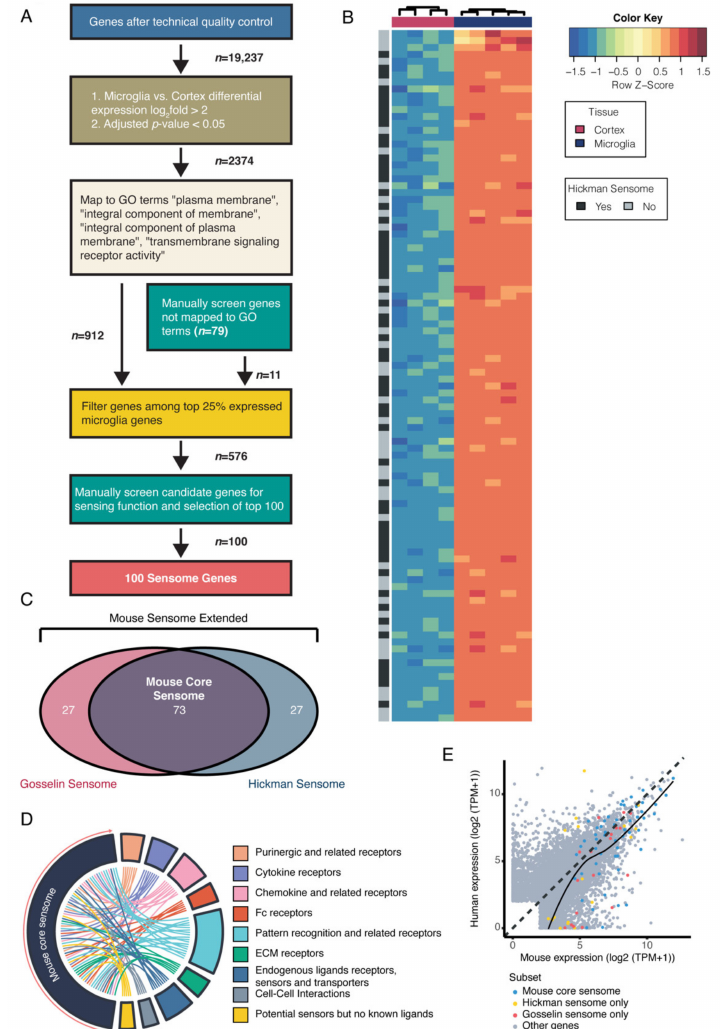
Figure 1. Identification of microglial mouse sensome shows major overlap between two independent datasets. ( A ) Flow chart showing selection of genes from the Gosselin et al. mouse datasets to identify the n = 576 candidate sensome genes. First, technical quality control was performed and genes with a low number of reads per sample were excluded. Second, differential expression analysis with a cut-off of log 2 fold >2 and p -adjusted value <0.05 was used to select genes significantly expressed by microglia. Third, using gene ontology (GO) annotation, we selected genes with association to “plasma membrane”, “integral component of membrane”, “integral component of plasma membrane”, and “transmembrane signaling receptor activity” (genes not mapped were manually curated). Fourth, the top 25% expressed genes were selected as candidate sensome genes. Finally, from the candidate sensome genes, the top 100 were manually verified using the criteria that these should express genes that translate in proteins that are present in the cell membrane and have a receptor-like function. In summary, these genes are highly expressed and specific to microglia and their respective proteins are located in the plasma membrane, where it has a receptor-like function. ( B ) Heatmap showing the first 100 sensome candidate genes (left to right) ordered by differential expression between cortex and microglia (low to high), with the upper row showing if the gene is present in “Hickman et al.”. (Supplementary Table S2). ( C ) Venn diagram showing the overlap between the top 100 Gosselin and Hickman mouse sensome genes (Supplementary Table S2). This total set is termed the “mouse sensome extended” and the shared set is called the “mouse core sensome”. ( D ) Circ plot showing the components of the 73 mouse overlapping sensome genes including the distribution of genes over the assigned subgroups. The genes are ordered based on log 2 fold differential expression (DE) extracted from the Gosselin dataset (microglia to cortex). ( E ) Scatterplot displaying the genes of the extended and overlapping mouse sensome, illustrating a minor enrichment of genes that are higher expressed in mice compared with humans. ECM, extracellular